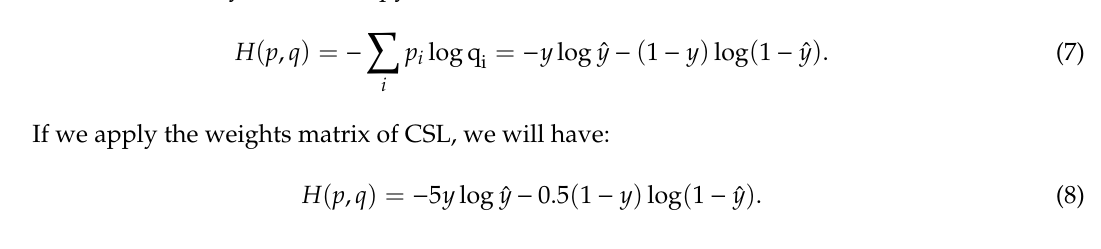
Table 2. Network hyperparameters.